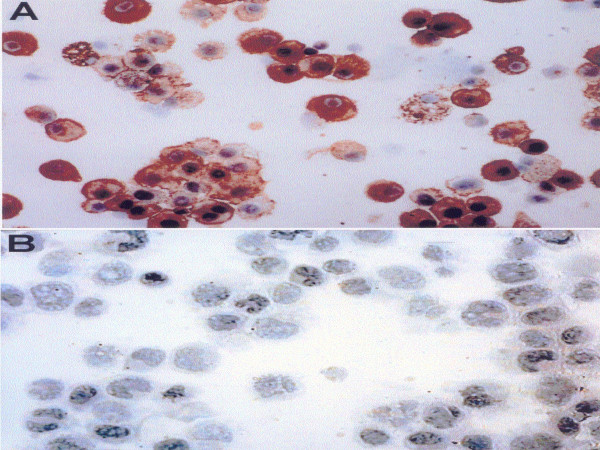
Cytospins with mAb SM5-1. Immunohistochemical staining (cytospin) of SMMUpos (A) or SMMUneg (B) cells with mAb SM5-1.